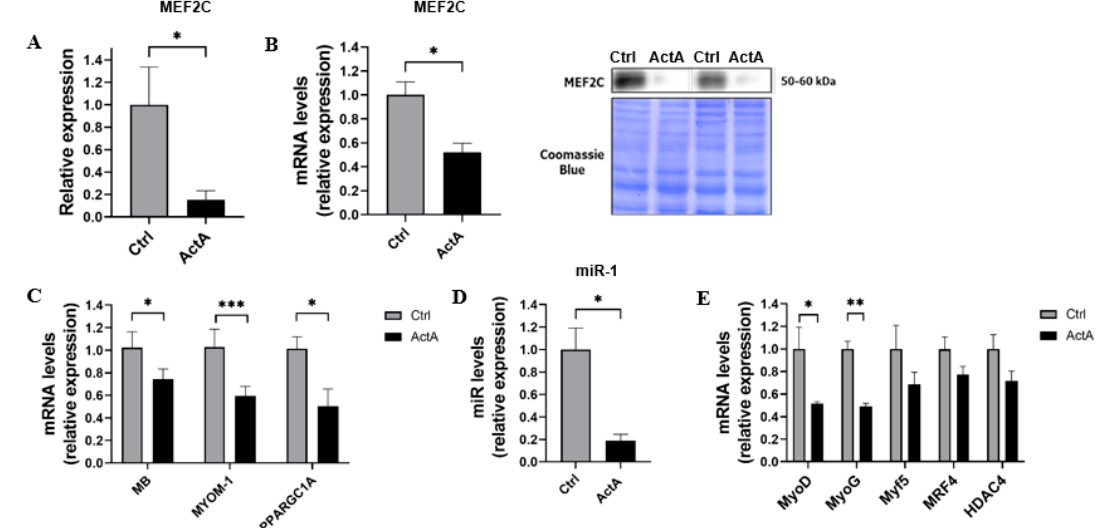
Figure 3. Activin A-induced myotube atrophy is associated with a downregulation of MEF2C expression and activity. ( A ) MEF2C content measured by western blot, ( B , C , E ) MEF2C , MB , MYOM-1 , PPARGC1A , MyoD , MyoG , Myf5 , MRF4 , and HDAC4 mRNA levels measured by RT-qPCR and ( D ) miR-1 expression, all measured 48 h after exposure to recombinant ActA or vehicle. Data are reported as means ± SEM (n = 5/condition). * p < 0.05, ** p < 0.01, and *** p < 0.001 vs.